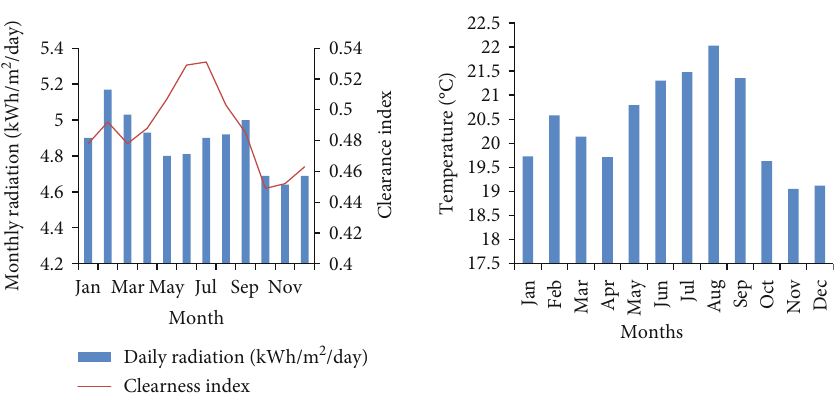
Figure 8: Climatic data for the case study location: (a) radiation and clearance index; (b) monthly temperature.